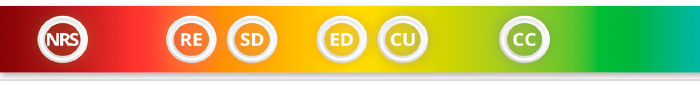
Figure 2. Workshop participants’ views on the status of community health using the Indigenous Health Indicators. (NRS = natural resources security; RE = resilience; SD = self-determination; ED = education; CU = cultural use; CC = community connection).